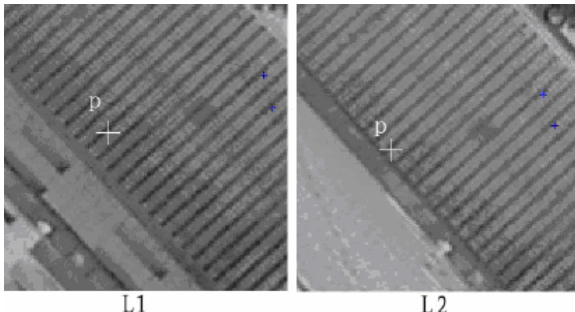
Figure 11. Experiment results under moving Z-Plane